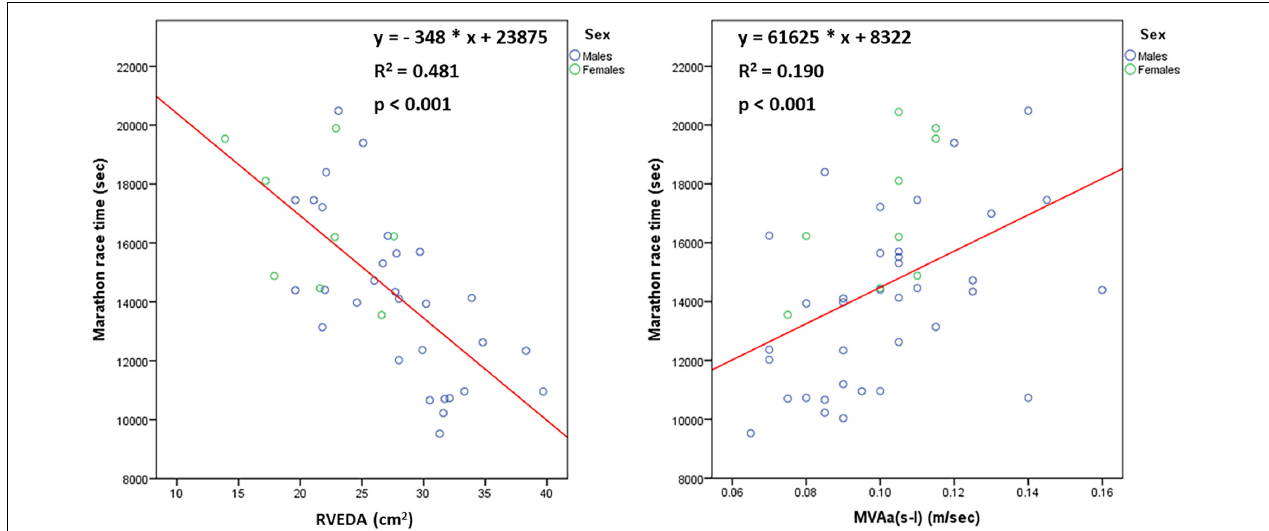
FIGURE 4 | The relationship [ n = 45 (36 males, 9 females)] of marathon race time with right ventricular end-diastolic area (RVEDA) and average of septal and lateral late diastolic mitral annular velocity [MVA(s-l)].